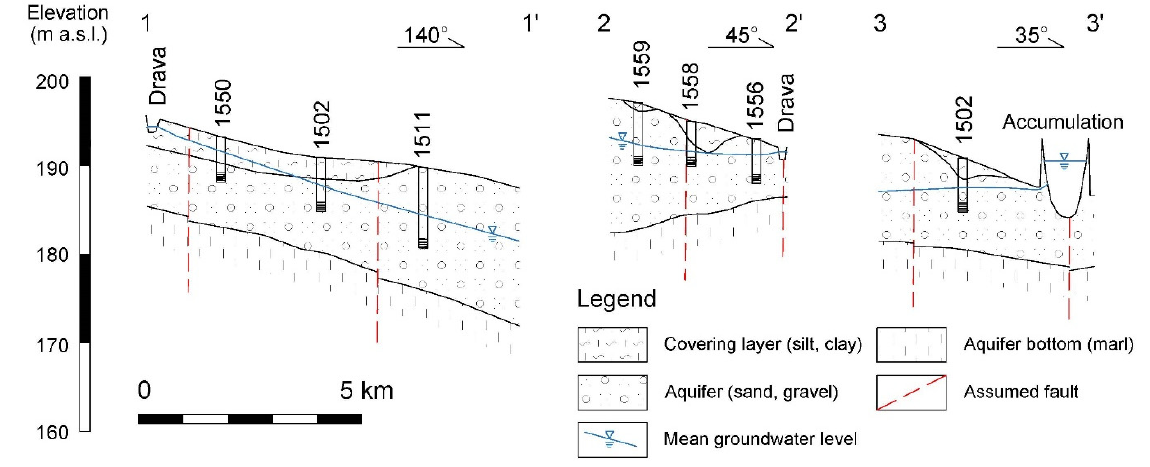
Figure 2. Schematic hydrogeological cross-sections across the NW edge of the Varaždin aquifer representing mean groundwater levels.